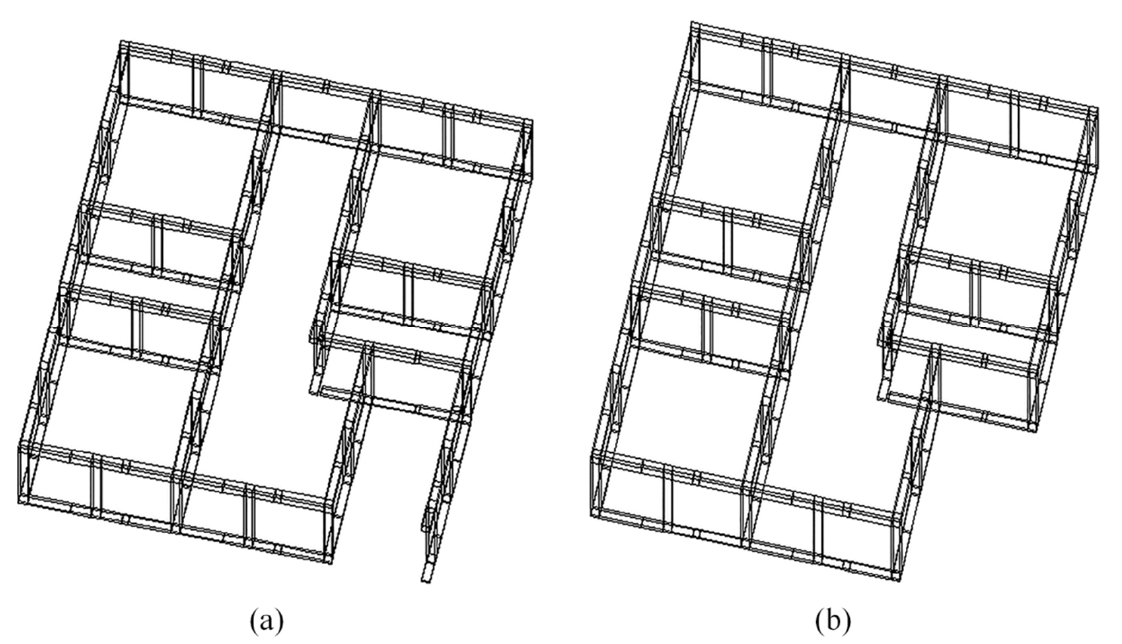
Figure 11. A 3D diagram of the prefabricated cantilever components arrangement: ( a ) First floor, ( b ) Second floor.